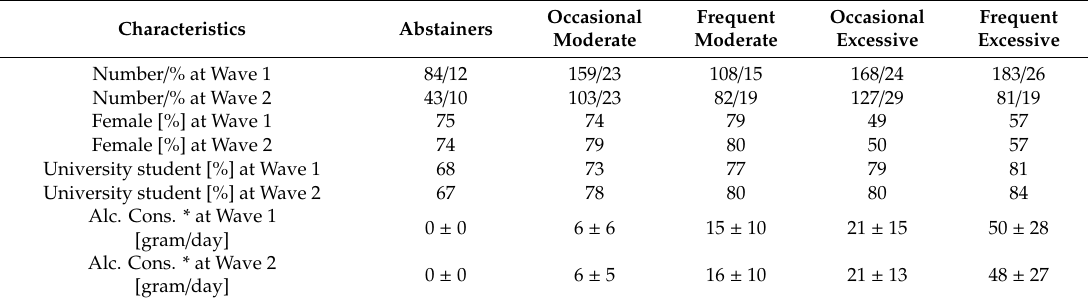
Table 2. Number and percentage students, percentage females, percentage University students, and average alcohol consumption in Wave 1 and Wave 2 in the various drinking